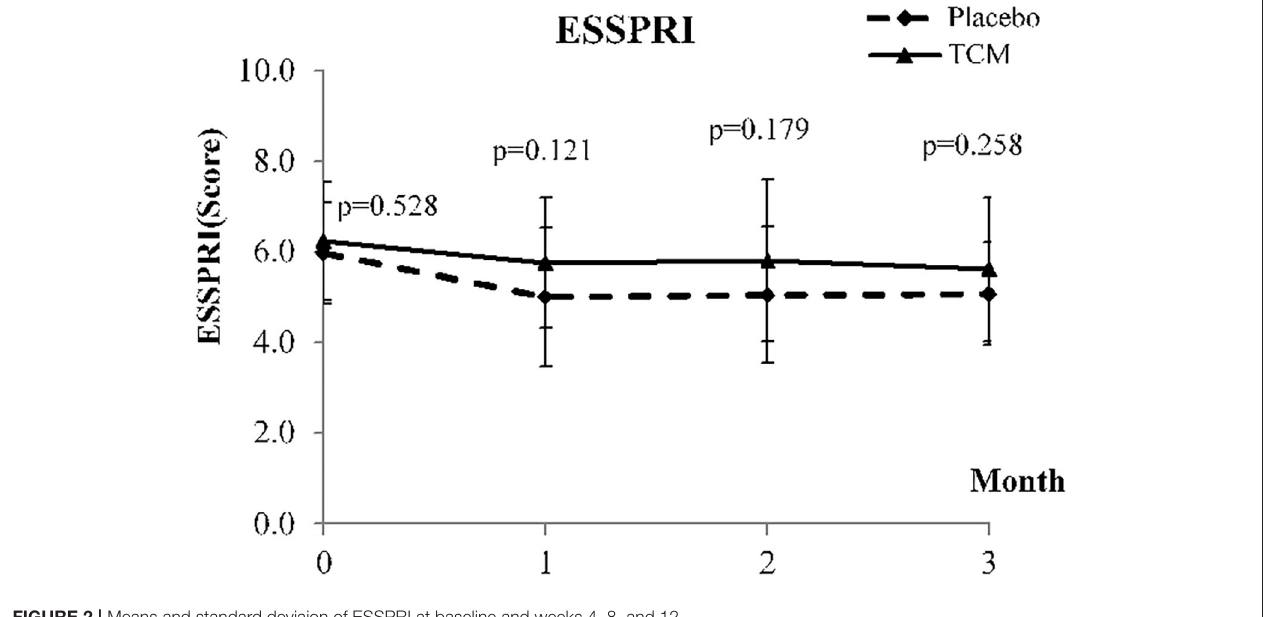
FIGURE 2 | Means and standard deviaion of ESSPRI at baseline and weeks 4, 8, and 12.